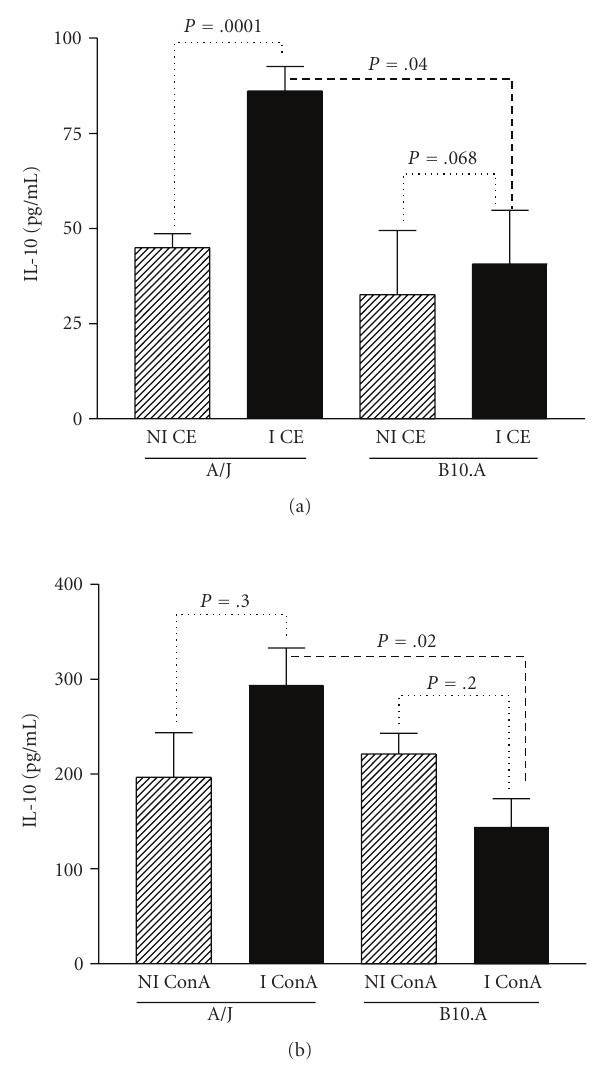
Figure 4: Level of IL-10 in the culture supernatant of spleen cells from A/J and B10.A mice nonimmunized (NI) and immunized (I) with the crude extract of L3 larvae of Lagochilascaris minor , stimulated with (a) ConA or (b) CE. Spleen cells were stimulated in vitro, and the supernatant collected after 48 hours. Cytokine production was considered positive if over the detection limit of 15pg/mL for IL-10. Bars represent the mean values ±